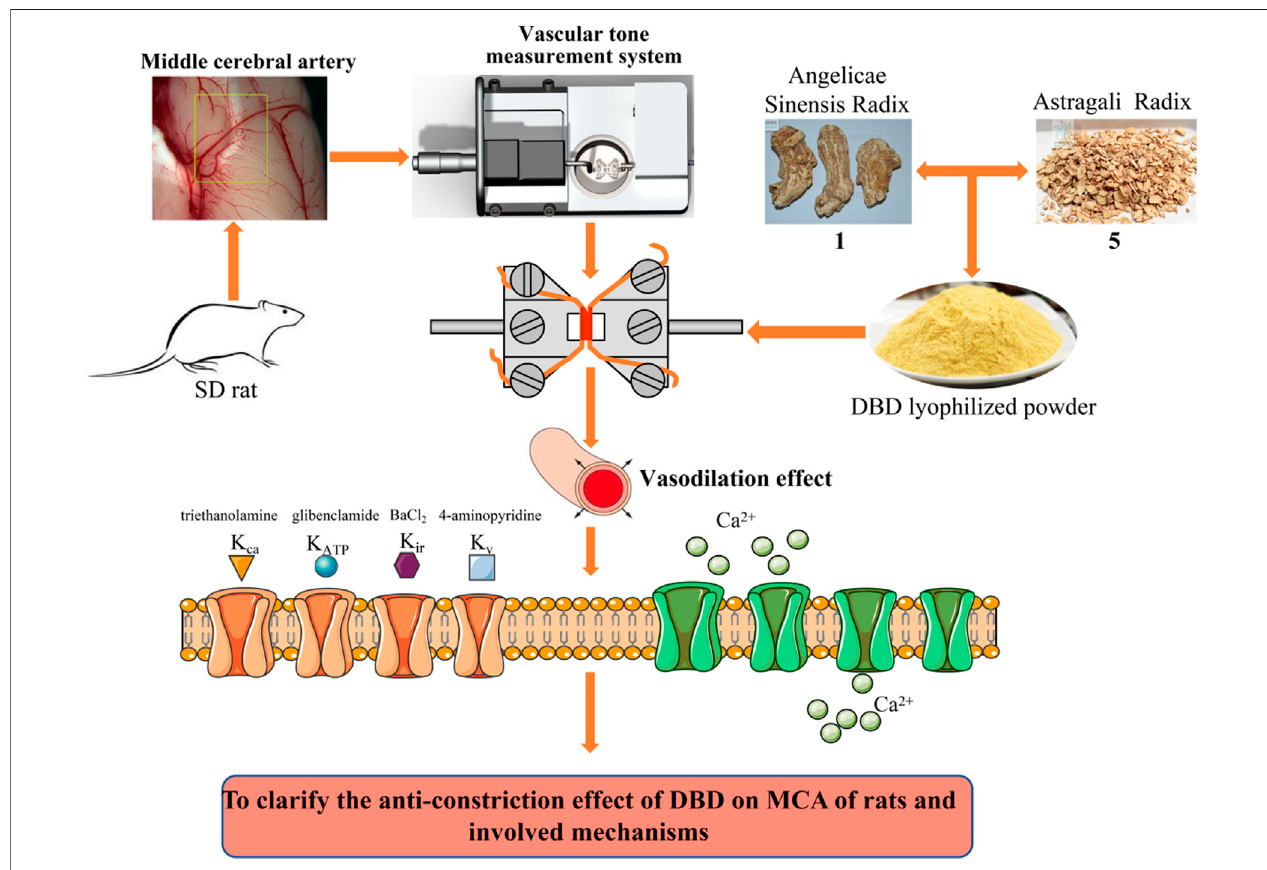
FIGURE 2 | Laboratory technology roadmap. After dissection and isolation of the MCA of rats, the changes of DBD, ASR, and AR on the vascular tension were monitored and recorded using the DMT620 M vascular tension detection system. The potential regulatory activities of K + and Ca 2+ channels were further demonstrated to clarify the anticonstriction effect by DBD, ASR, and AR. AR, Astragali Radix. ASR, Angelicae Sinensis Radix. DBD, Danggui Buxue decoction. MCA, middle cerebral artery.